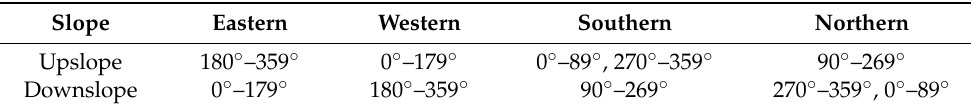
Table 5. Slope classification table of Malus sieversii on different hillsides under custom coordinate system.